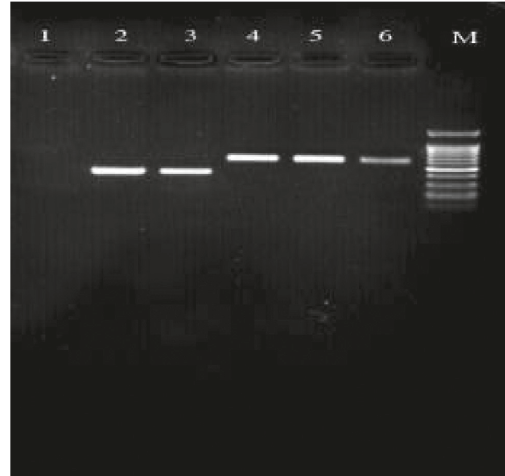
Figure 10: PCR product electrophoresis of 593bp bla and 642bp bla VEB gene (from left, lane 1: negative control, lanes 2 and 3: positive samples of 593 bla CTX -M bp, lanes 4 and 5: positive samples of 642bp bla VEB gene, lane 6: positive control, and lane M: marker